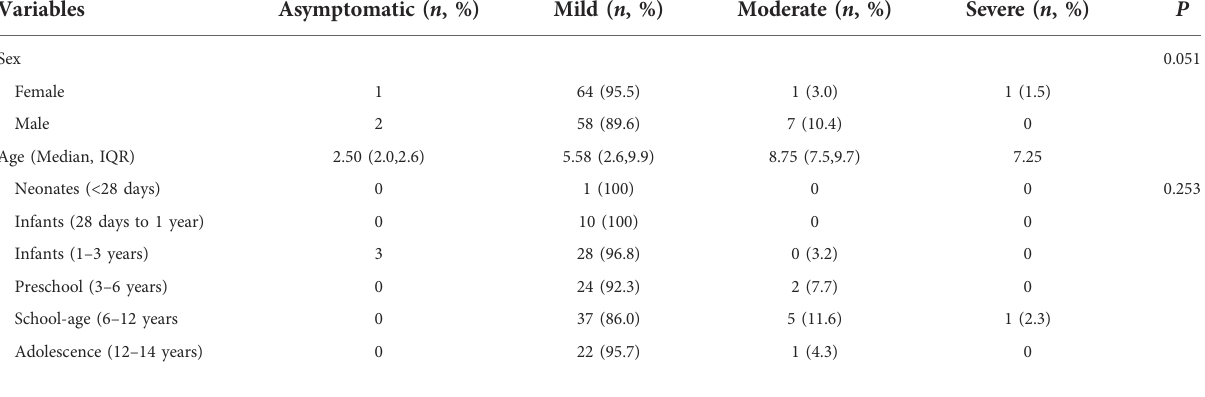
TABLE 2 Main symptoms of included children with omicron